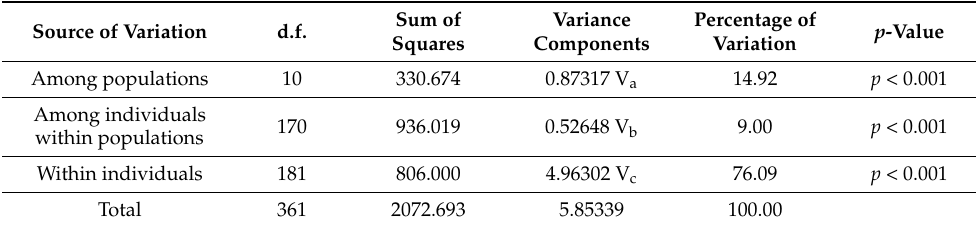
Table 4. Analysis of molecular variance (AMOVA) showing the population genetic structure of the Tor spp.